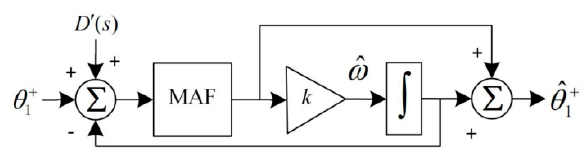
Figure 10. Small-signal model of QT1-PLL.